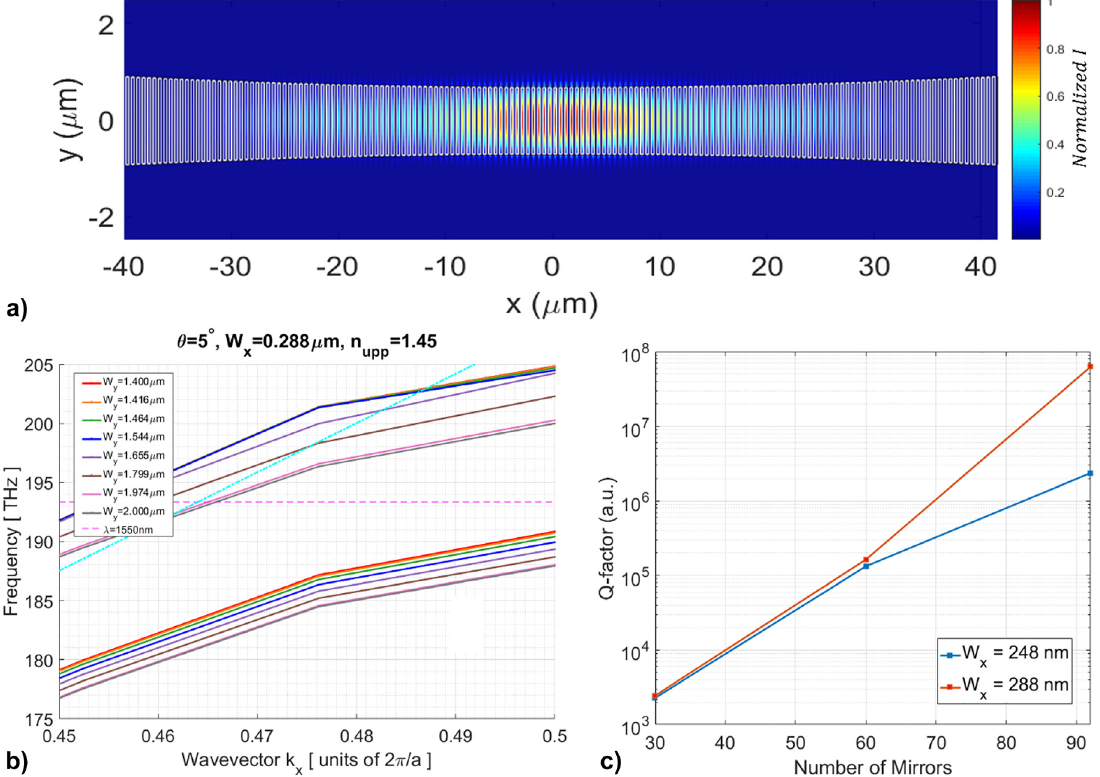
Figure 3: PhC cavity design, (a) Calculated 1D PhC cavity optical resonance for the configuration with one of the tightest optical confinement with silica cladding case and quadratic tapering with normalised intensity, achieving a Q-factor of ∼ 70 M, (b) photonic band diagram of the silica cladded 1D PhC cavity, turquoise dashed line corresponds to the silica light-lines, (c) Calculated Q-factors against the numbers of mirrors (periods of the 1D